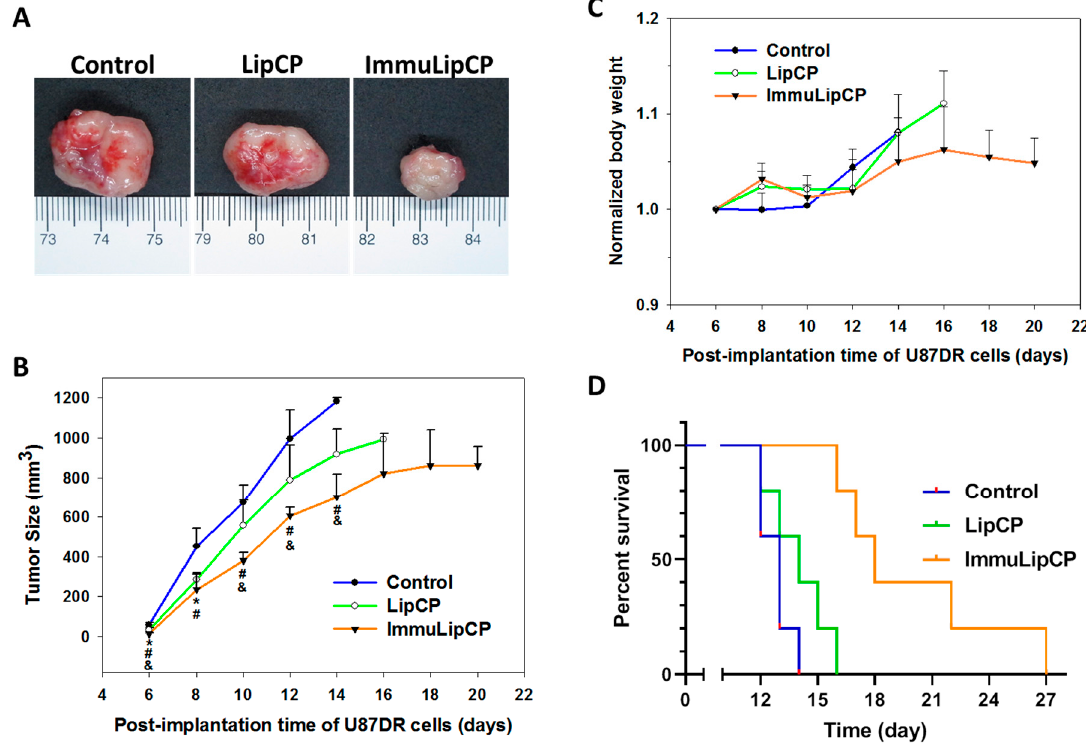
Figure 10. The in vivo anti-tumor efficacy was studied using a xenograft tumor model in nude mice by subcutaneous implantation of U87DR cells. The mice were divided into 3 groups and subject to intravenous injection of 100 μ L of PBS (control), LipCP (7 mg/mL) or ImmuLipCP (7 mg/mL) on day 6, 8, 10 and 12. ( A ) The gross view of tumors retrieved on day 14. ( B ) The efficacy of treatment was evaluated from change of tumor size with time ( n = 5). * p < 0.05, LipCP vs control; # p < 0.05 ImmuLipCP vs control; & p < 0.05 ImmuLipCP vs LipCP. ( C ) The change of body weight with time ( n = 5). ( D ) The survival curve as obtained from the survival time of mice by sacrificing the animal when the tumor volume exceeds 1000 mm 3 ( n = 5). Table 2. Survival times for U87DR tumor-bearing mice after different treatments.